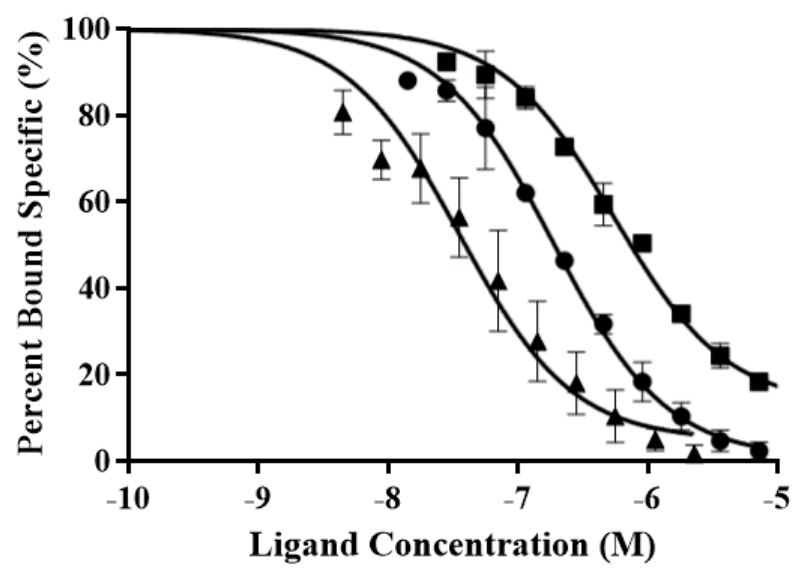
Figure 2. Competitive Radioligand Binding Assay for the Inhibition of [ 3 H]-8-hydroxy-DPAT with 2-fluorophenyl Compounds at 5-HT1A Receptors . 2-Fluorophenyl piperazine compounds 3a (– ● –), 6a (– ■ –), and 7a (– ▲ –) were evaluated for their affinity at 5-HT1A receptor using competitive radioligand binding techniques. K i values were determined by at least three experiments. Compound 7a exhibited the highest affinity for the 5-HT1A receptor (K i = 14.3 ± 7.1 nM) while compound 6a had the lowest affinity for the receptor (K i = 199 ± 34.3 nM). The orthosteric fragment, compound 3a , exhibited an intermediate affinity for 5-HT1A receptors (K i = 67.8 ± 4.6 nM). This rank-order of affinity is consistent with the results obtained in affinity displacement screen shown in Table 2.